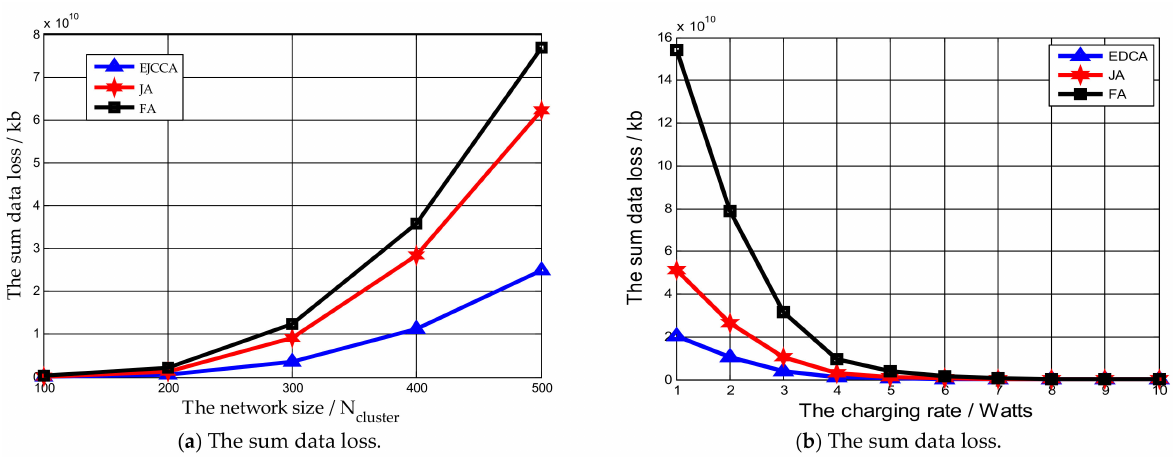
Figure 5. The influences of different parameters on the data